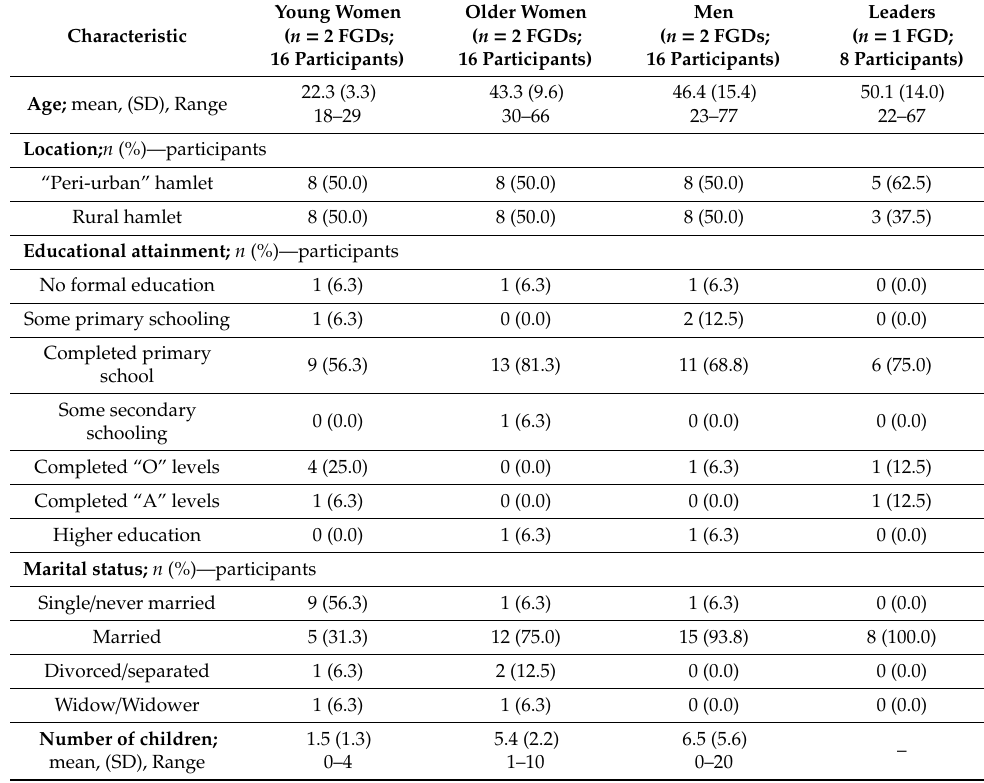
Table 1. Summary of respondent characteristics engaged in focus group discussions in Geita region Tanzania, by respondent group.